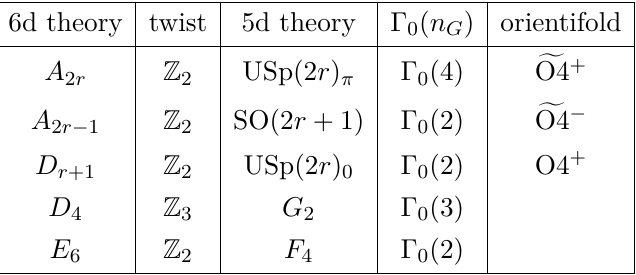
Table 1 . Twisted compactification of 6d (2 , 0)